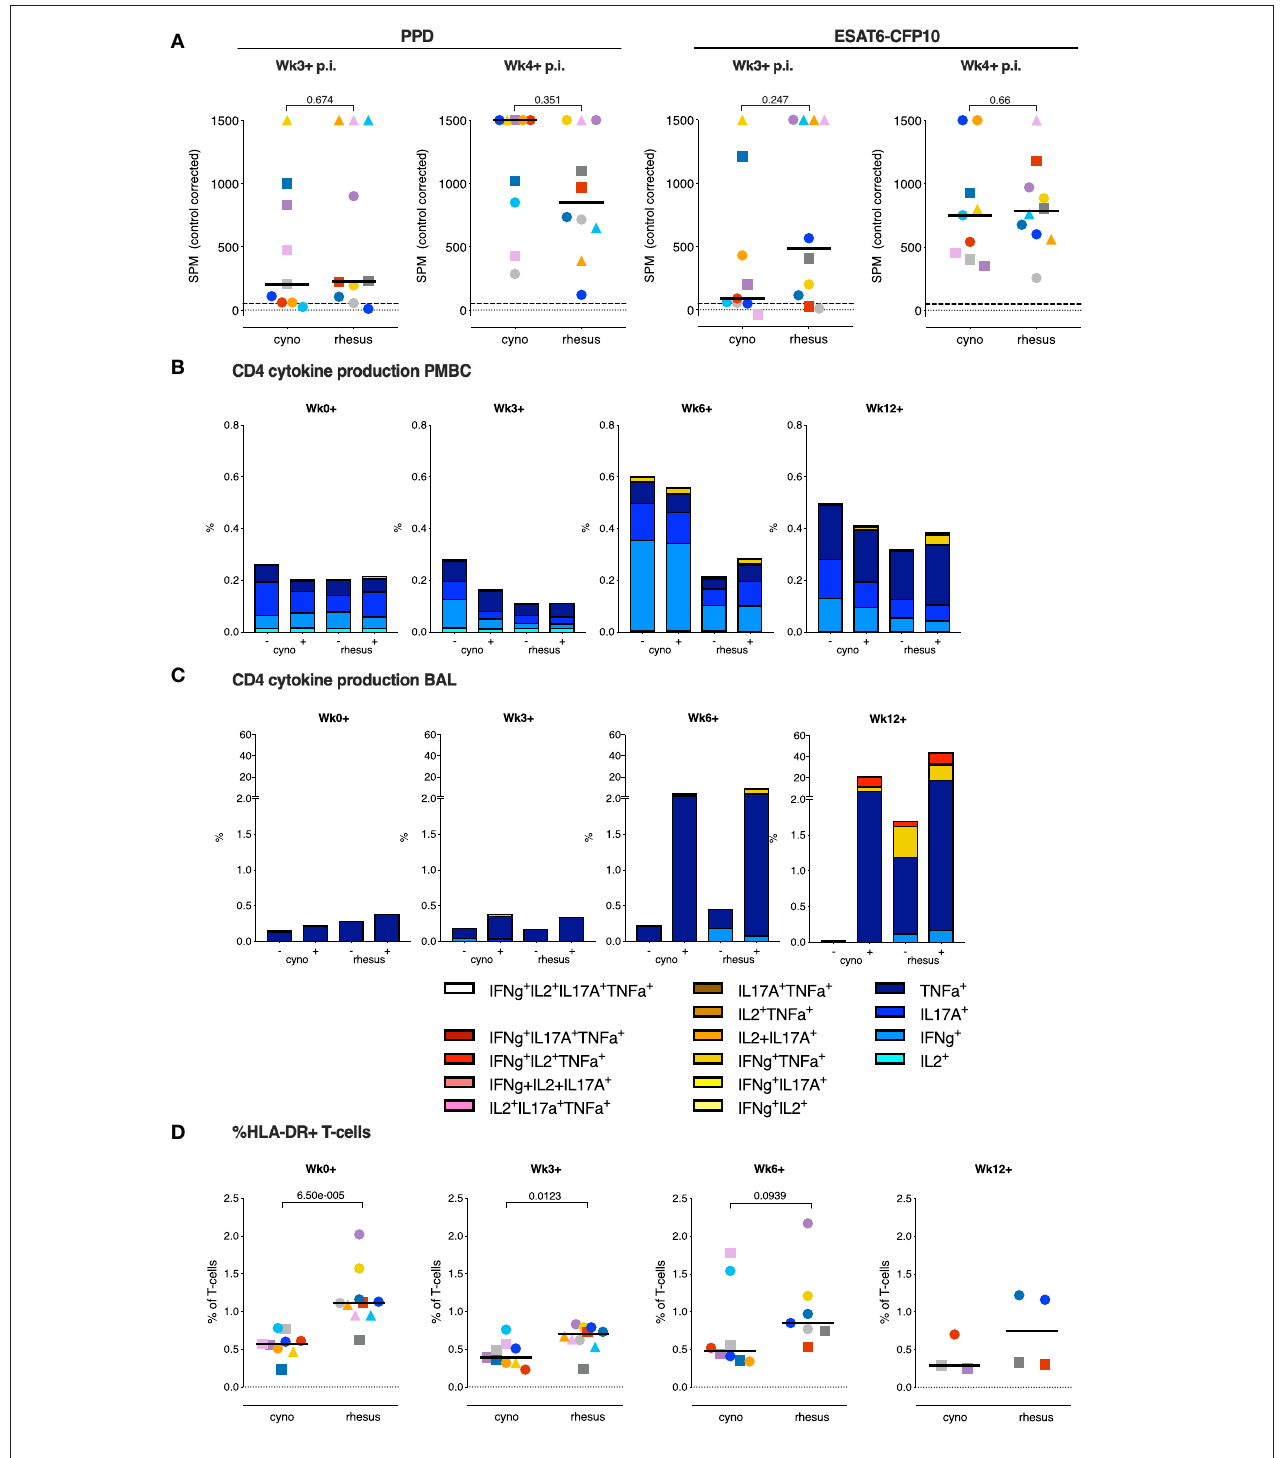
FIGURE 4 | T lymphocyte cytokine responses do not associate with the differential disease outcome between species. (A) The IFN γ ELISPOT response to PPD and ESAT6-CFP10 recall stimulation in vitro , 3 or 4 weeks post- Mtb infection take (p.i.; median of triplicates per animal). (B) Median frequency of cytokine producing CD4 + T-cell subsets in PBMC, and (C) in BAL, both after overnight stimulation with culture medium as a control (–) or Mtb -derived PPD ( + ). (D) Frequencies of circulating HLA-DR + T-cells. Data are aligned to the moment of each individual’s time point of infection take. Number of animals per time point varies due to sample availability. Horizontal lines indicate group medians in (A,D) ; dashed lines in (A) mark the cut-off value for positivity in the ELISPOT assay. P -values of possible differences between species was determined by two-sided Mann-Whitney testing. Color coding per individual, as defined in Table 1 , is consistently applied throughout.